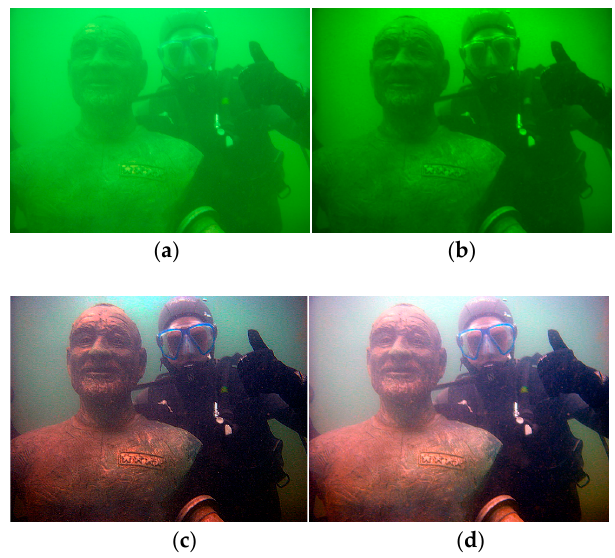
Figure 9. ( a ) Original underwater image processed with ( b ) AMEF ( c = 0.1) ( c , d )